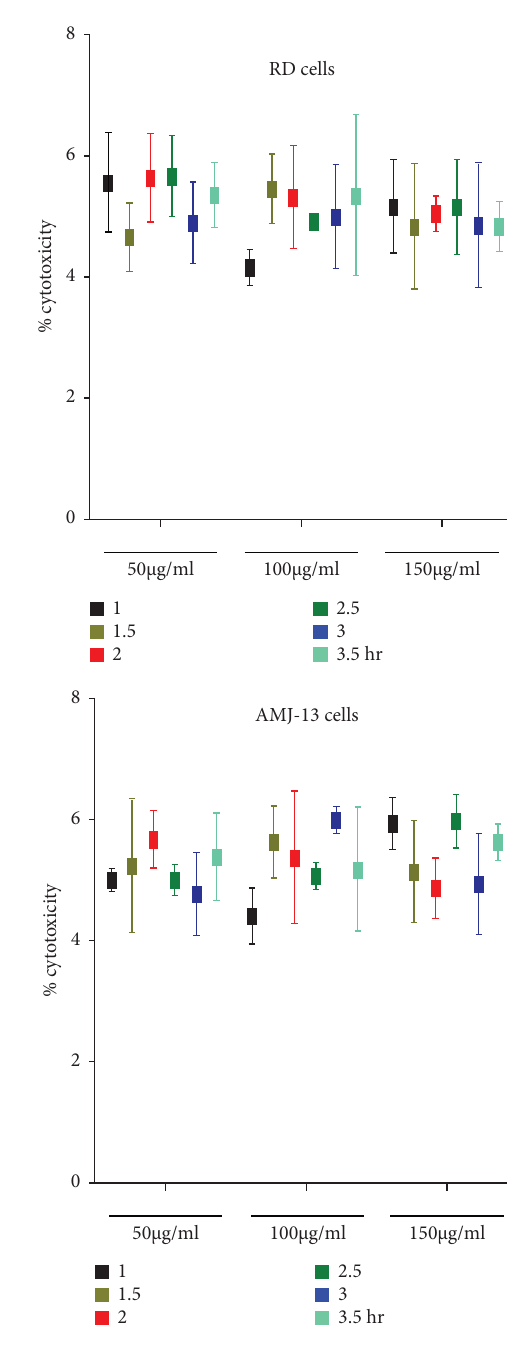
Figure 2: ZnO NPs cytotoxic activity against cancer and normal cell line. Data in the MTT test are represented by mean ±